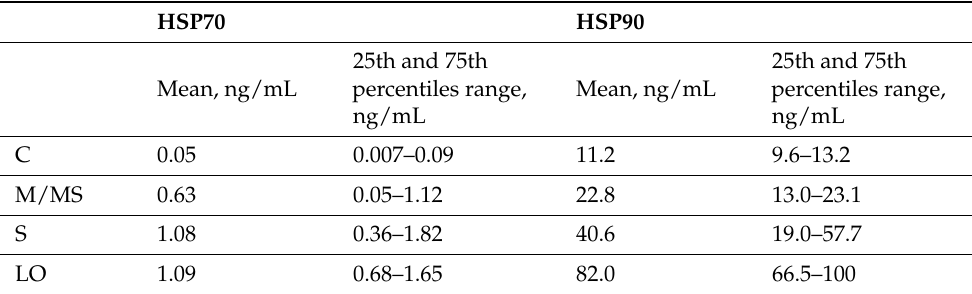
Table 1. The statistical data of HSPs concentration found in control (C), mild (M), moderately severe (MS), severe (S), and lethal outcomes (LO)